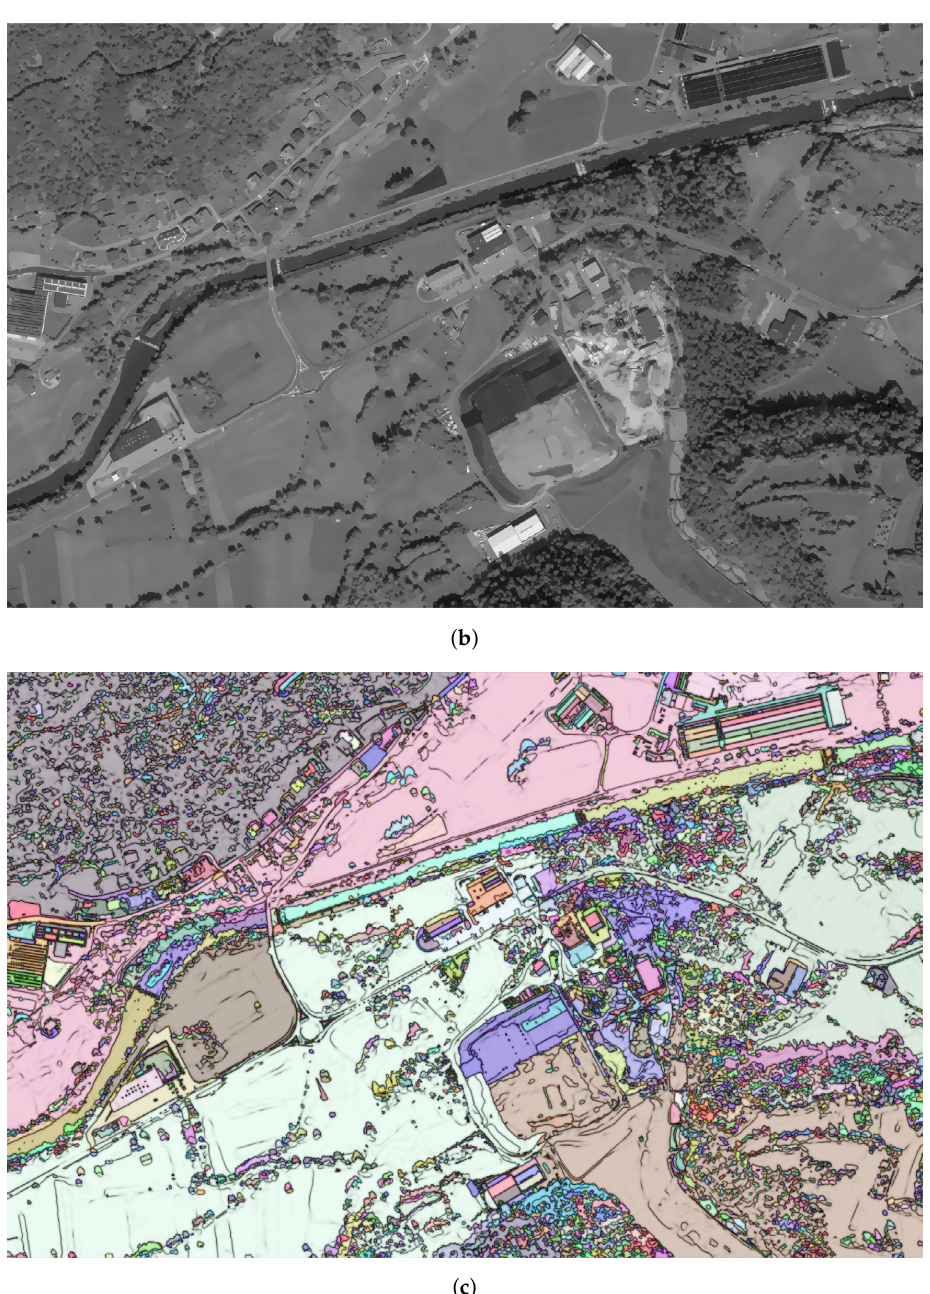
Figure 7. WorldView-3 image and intermediate maps. ( a ) panchromatic band; ( b ) variational approximation u of WorldView- 3 Panchromatic band Figure 7a; ( c ) discontinuity function s with clumps of the variational approximation of the base image Figure